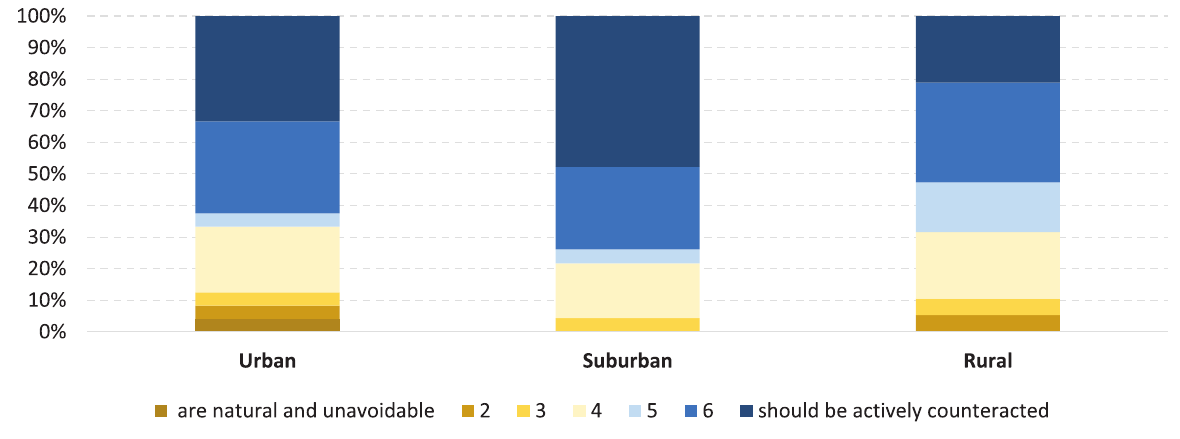
Figure 1. Opinions on spatial